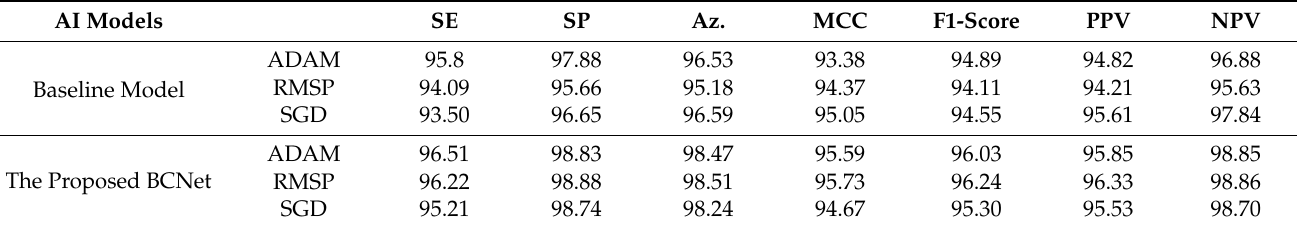
Table 5. The compression evaluation result of the ablation